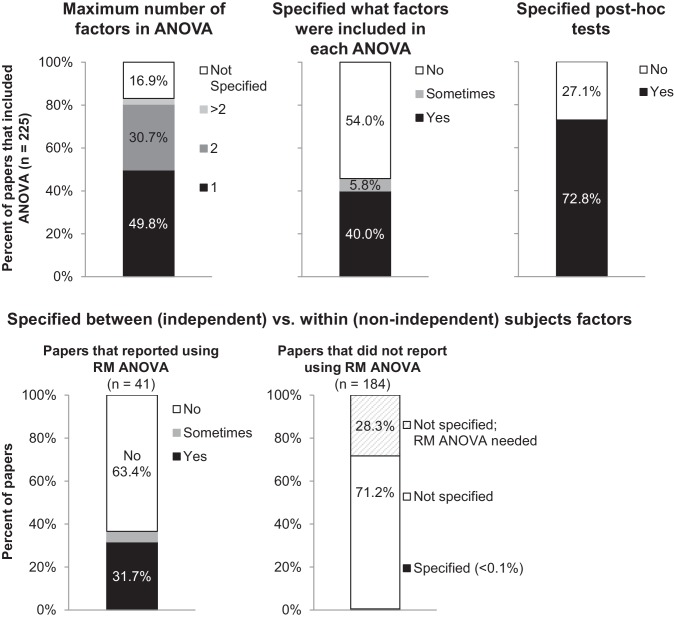
Many papers lack the information needed to determine what type of ANOVA was performed.The figure illustrates the proportion of papers in our sample that reported information needed to determine what type of ANOVA was performed, including the number of factors, the names of factors, and the type of post-hoc tests. The top panel presents the proportion of all papers that included ANOVA (n = 225). 'Sometimes' indicates that the information was reported for some ANOVAs but not others. The bottom row examines the proportion of papers that specified whether each factor was between vs. within-subjects. Papers are subdivided into those that reported using repeated measures ANOVA (n = 41), and those that did not report using repeated measures ANOVA (n = 184). RM: repeated measures.